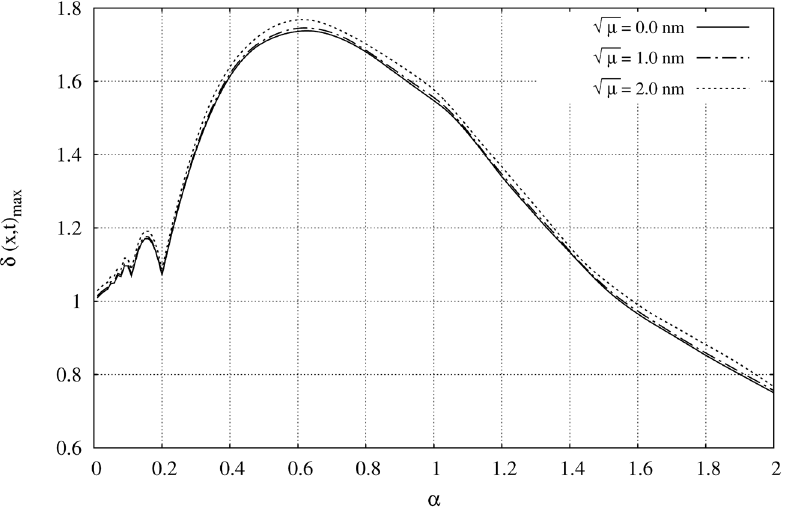
= 0, P / g = 0, γ = 0.0. w i Table 6 Maximum relative deflection and corresponding velocity parameter in Figure 6, l/d =